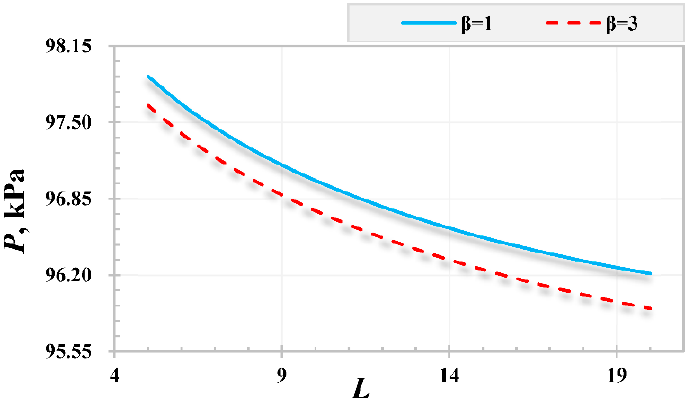
Figure 11. Pressure drop law of coal seam in multi-well fracturing reservoir.